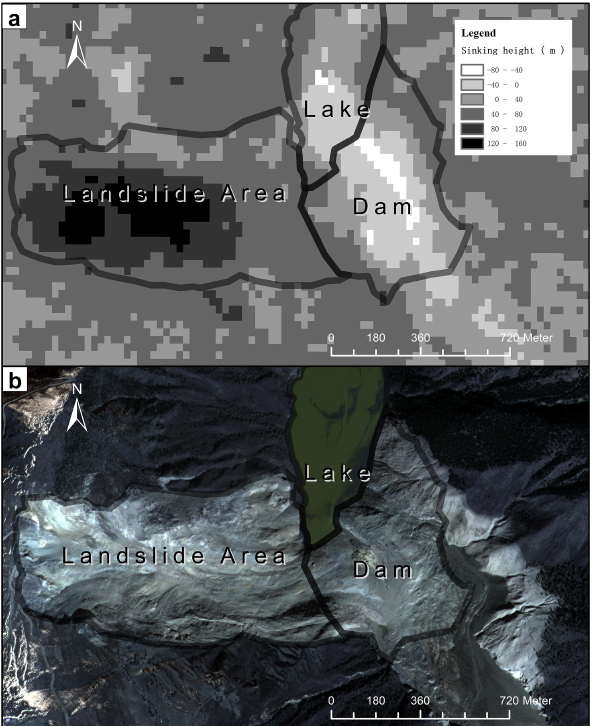
Figure 1. Panel (a) is a comparison of the pre-landslide DEM (SRTM V3) with the after-landslide DEM. Panel (b) is a re- mote sensing image from the Beijing-1 satellite (taken on 9 Novem- ber